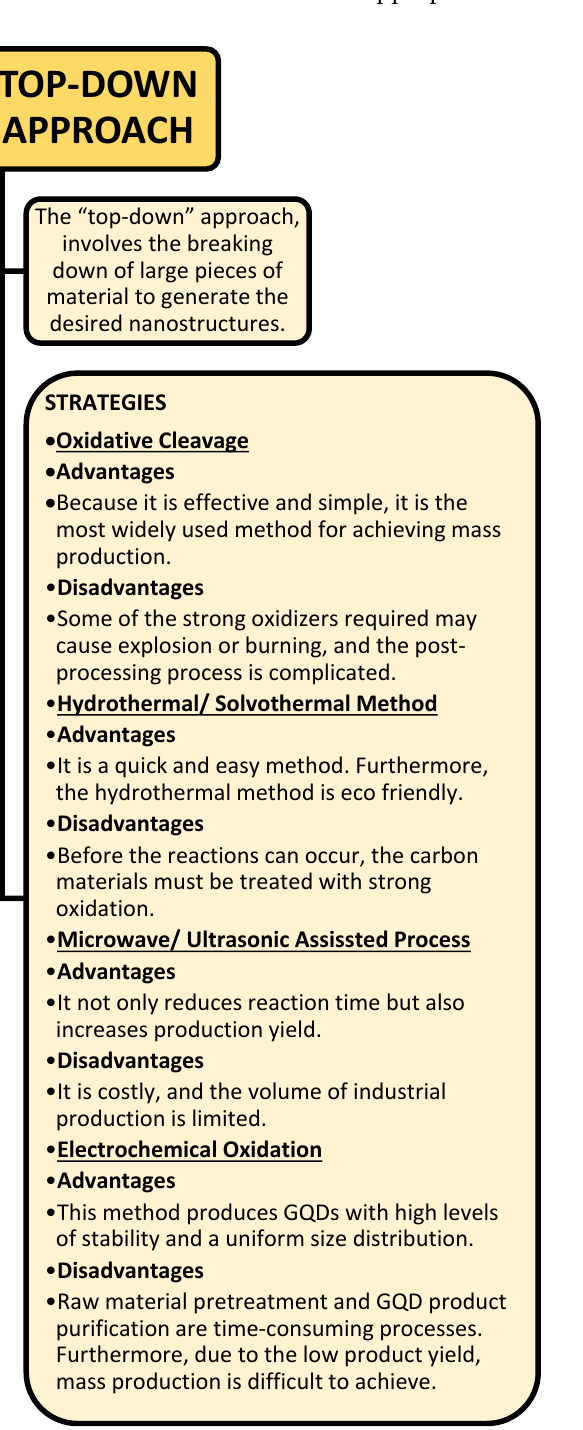
Figure 15. Advantages and disadvantages of various strategies of top-down and bottom-up approach for the greener synthesis of GQDs.